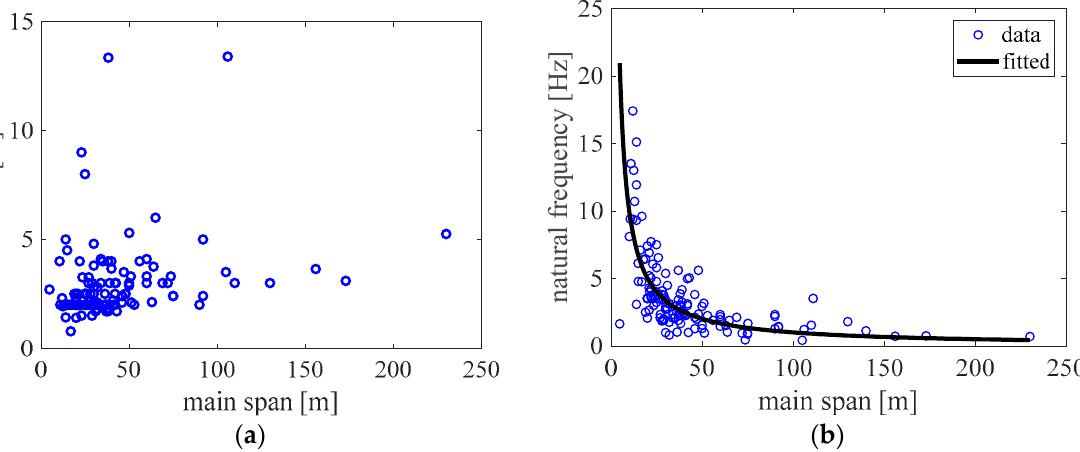
Figure 3. Plots of ( a ) main widths and ( b ) fundamental natural frequencies of the vertical modes over the main spans of constructed footbridges.